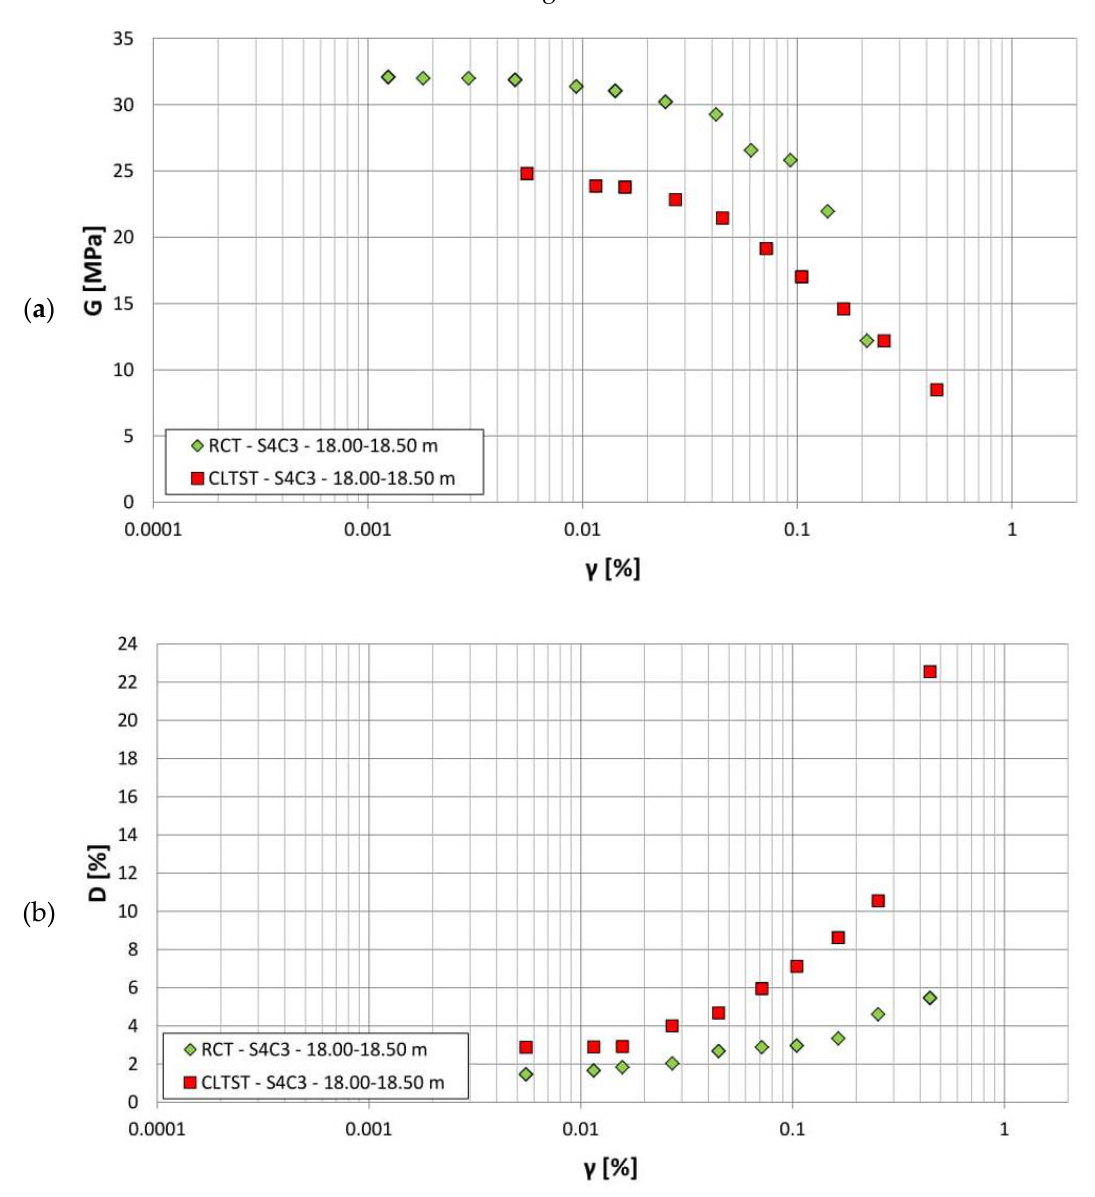
Figure 10. ( a ) G [MPa] versus γ [%] curves. ( b ) D [%] versus γ [%] curves (for S4C3 soil sample). The position of the equipment is reported in Figure 5. The foundation consists of an octagonal plate (maximum width of 3.50 m and thickness of 1.00 m) on six piles with a diameter of 500 mm and length of 12.00 m. The plate is set on a layer of lean concrete situated at a depth of 2.00 m. The pedestal (maximum width of 2.10 m and thickness of 1.20 m) has an octagonal section and it is equipped with eight anchor bolts for docking with the equipment. Plan and profile views of the basement are reported in Figures 12 and 13,